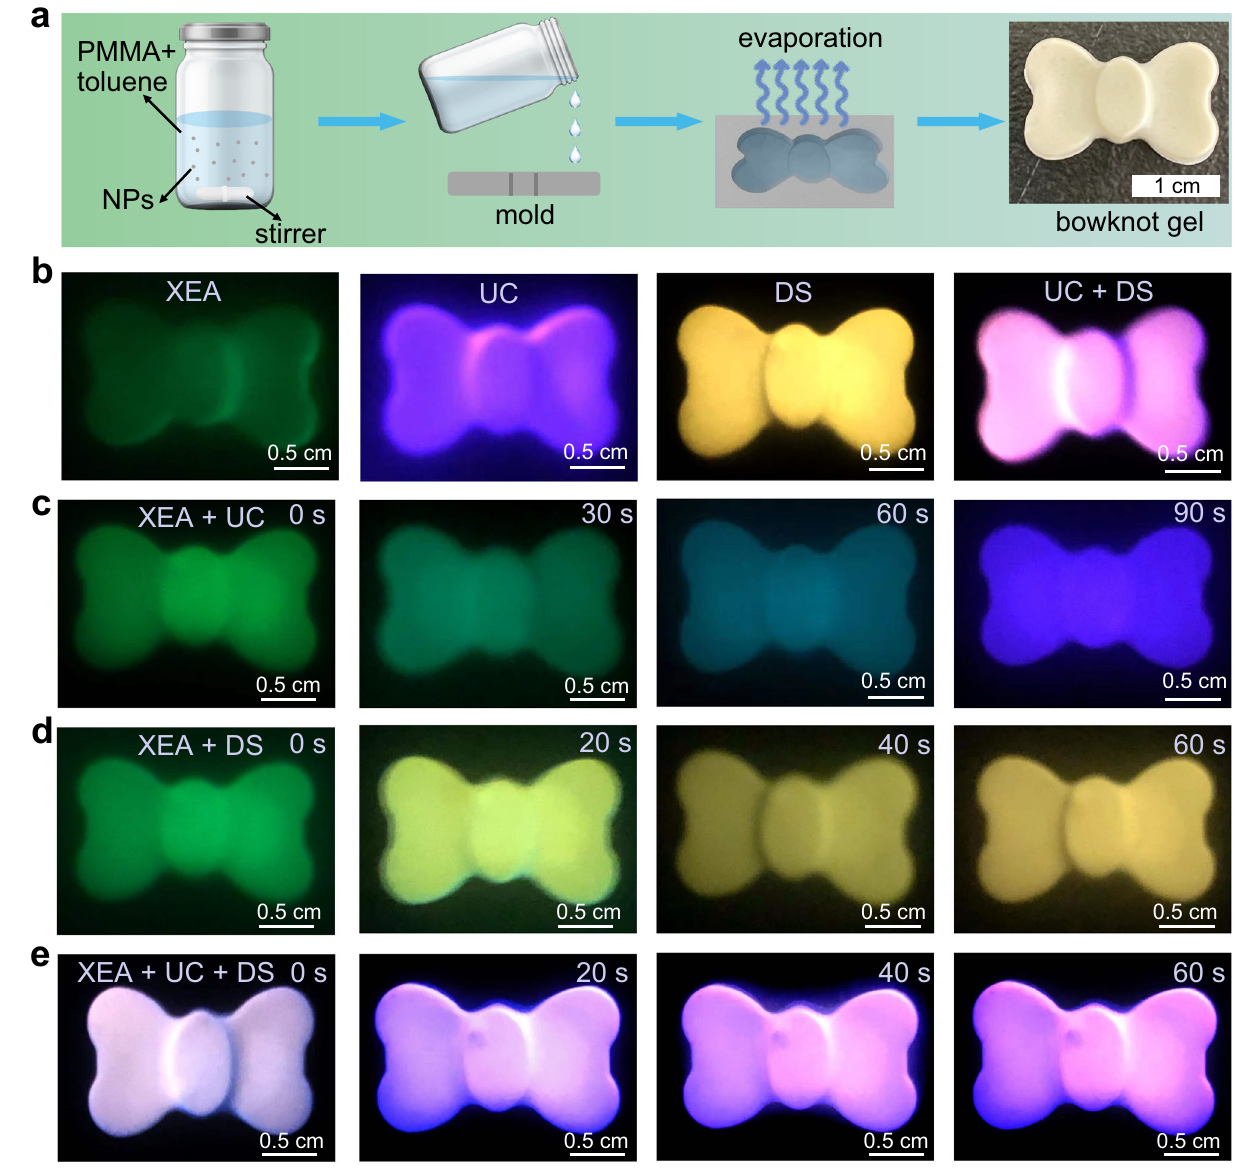
Fig. 5 | Demonstration of time-dependent colour editing using fl uoride-based core@shell@shell NPs. a Schematic illustration for the synthetic procedures of bowknot gel. b Photographs of the bowknot underdifferent excitation conditions. X-rays: 20 KV, 5min. Time-dependent photographs of the pre-X-ray-irradiated